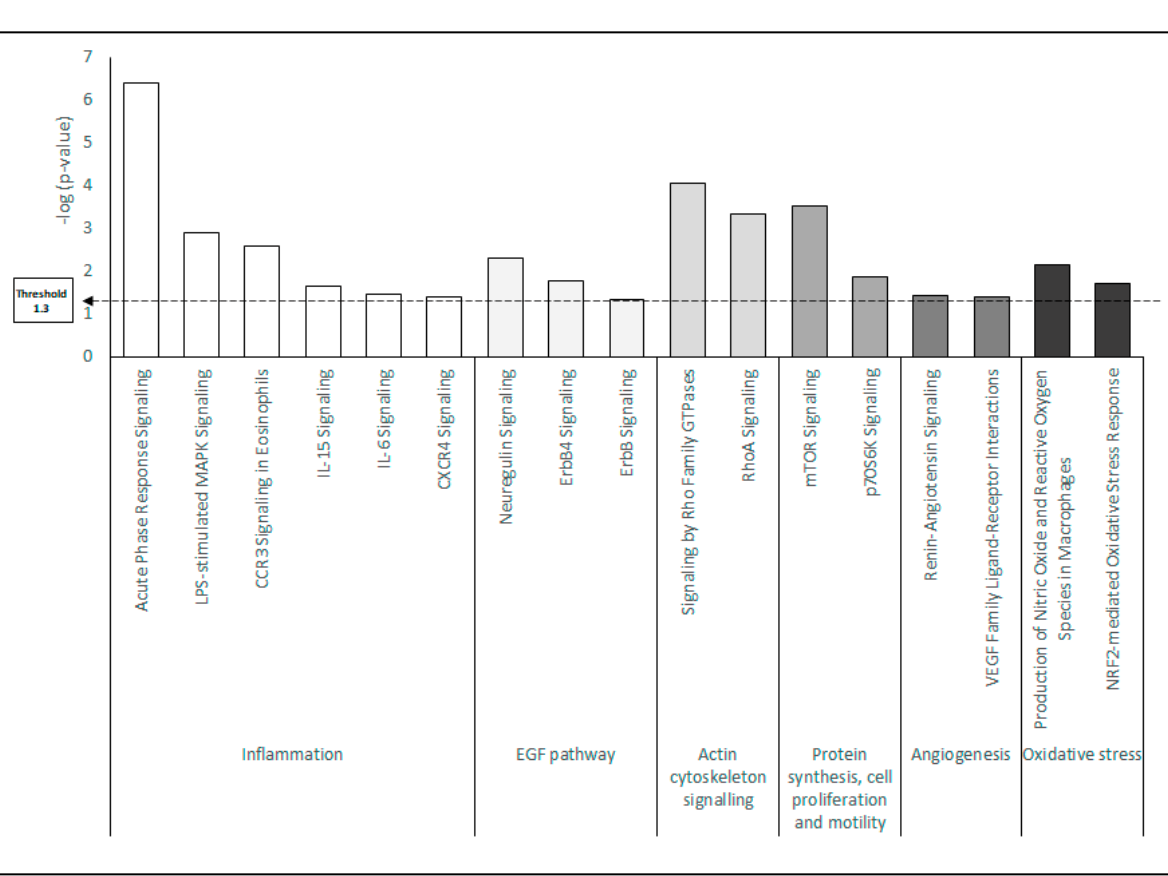
Figure 3. Canonical pathway analysis of the differentially expressed proteins in HK cells after treatment with PRGF or AS. The most significantly enriched canonical pathways ( − log p values in the y axis) are displayed. The results are clustered in functionally related groups of processes: Inflammation; EGF pathway; Actin cytoskeleton signaling; Protein synthesis, cell proliferation and motility; Angiogenesis; and Oxidative stress.